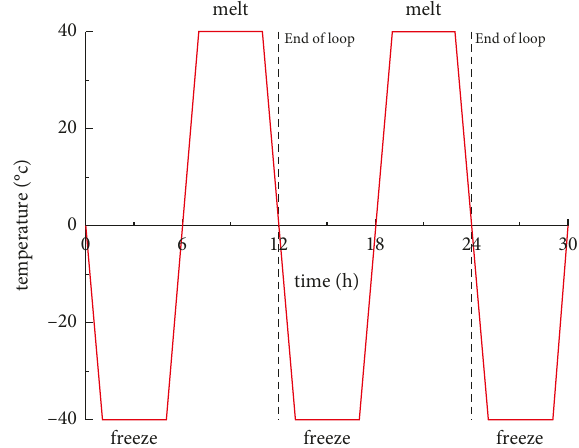
Figure 2: Schematic diagram of the freeze-thaw cycle.